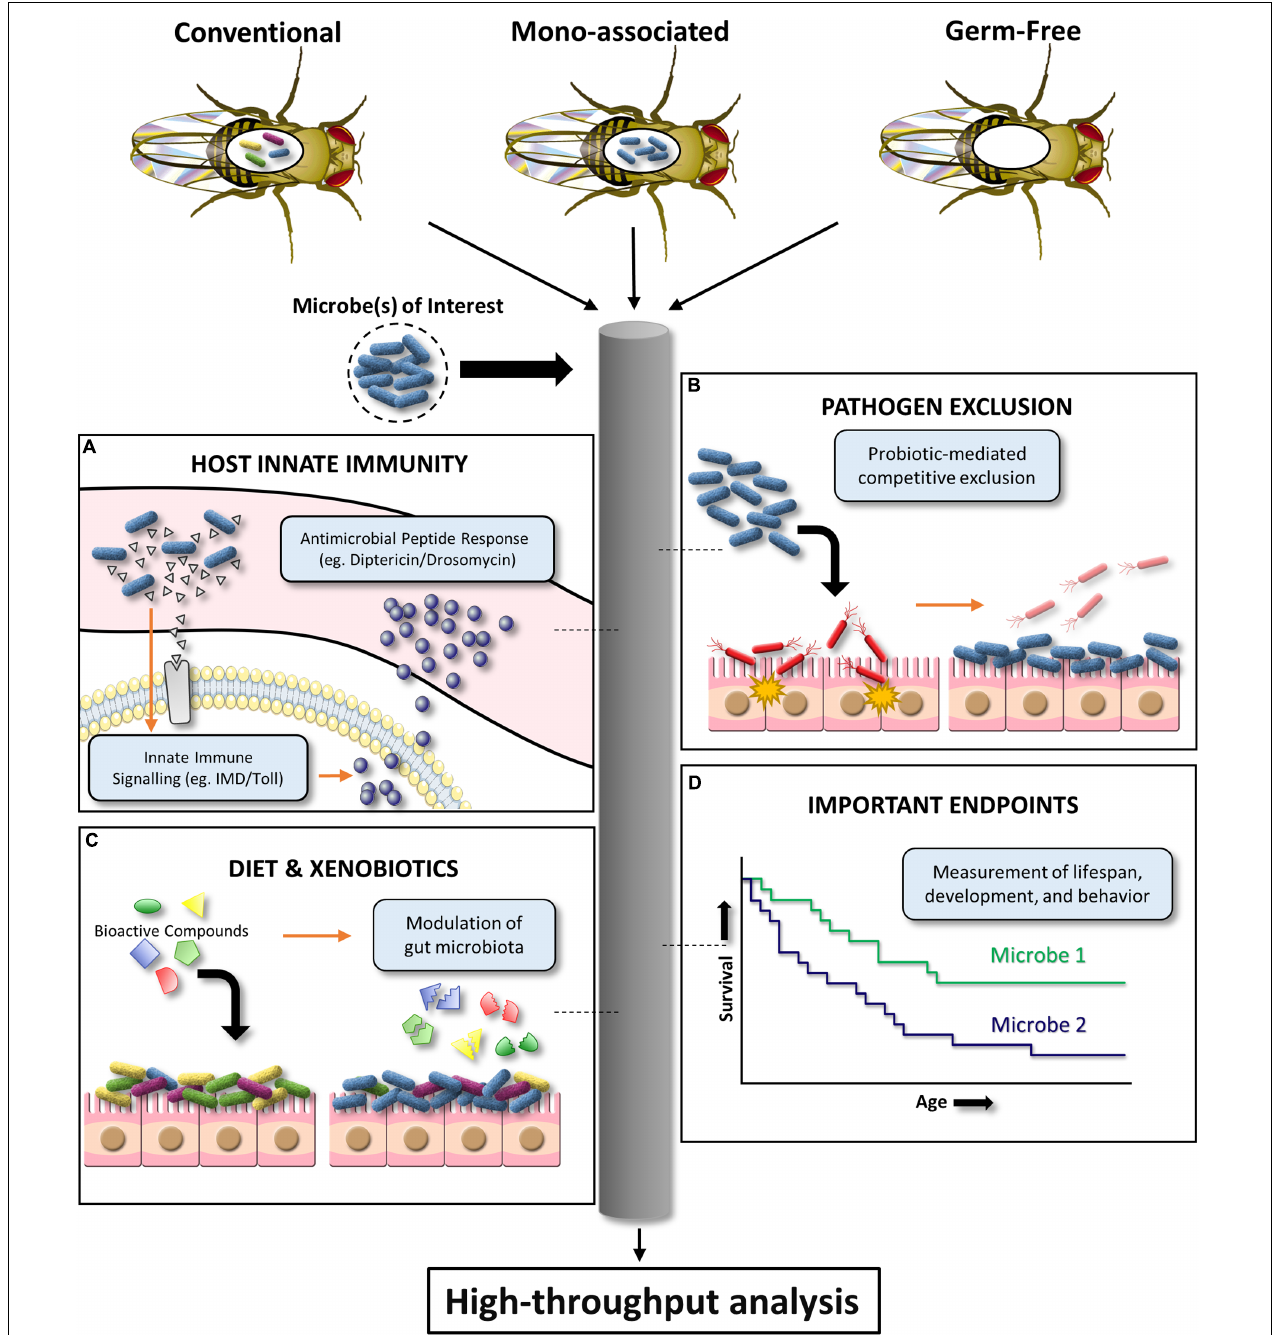
FIGURE 2 | Schematic diagram illustrating the high-throughput potential of D. melanogaster to investigate host–microbe interactions. Conventional, mono-associated, and germ-free D. melanogaster can be used to mechanistically dissect the effects of a given microbe on (A) innate immune system signaling, (B) pathogen exclusion, (C) xenobiotic biotransformation and associated effects on the microbiota, and (D) important endpoints such as lifespan, development, and